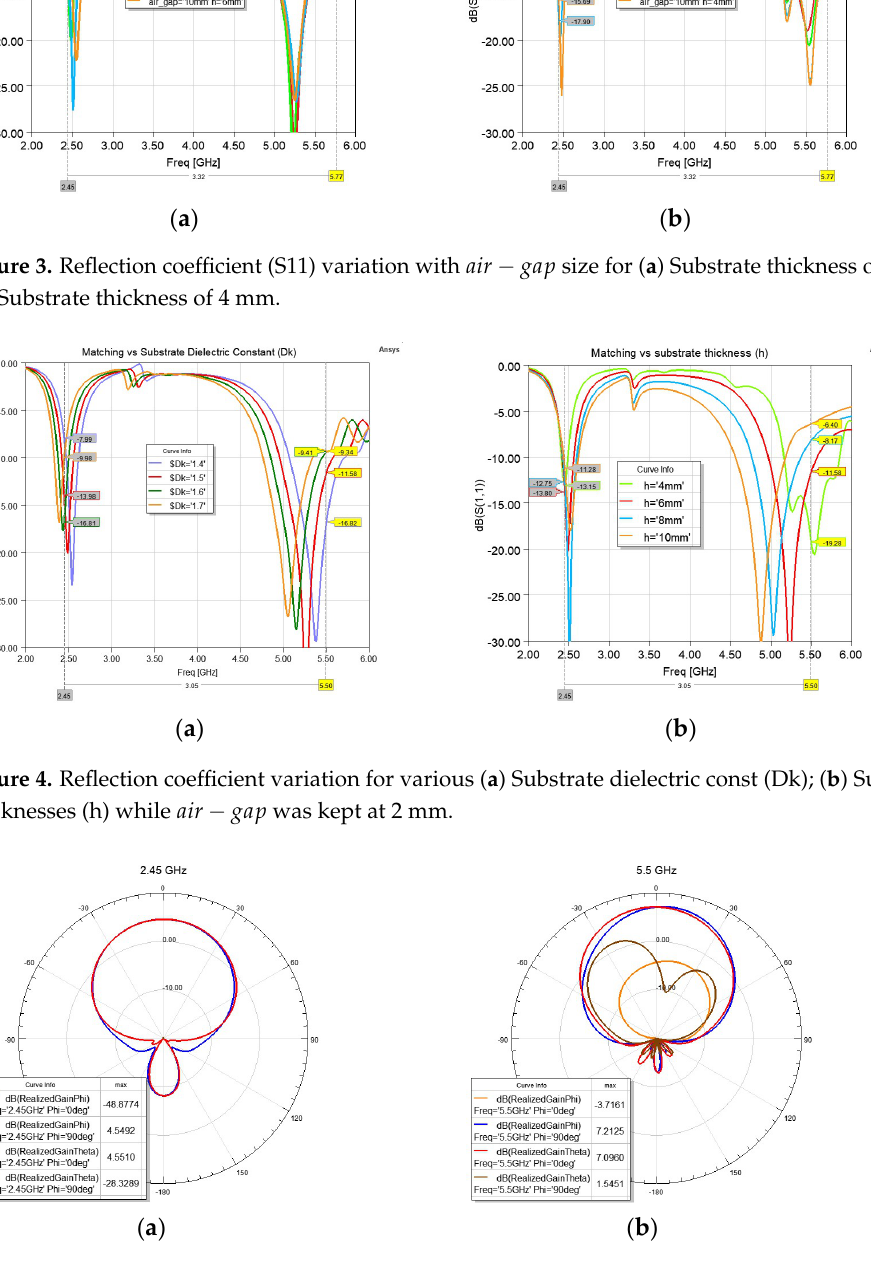
Figure 5. Radiation patterns for the antenna on a 6 mm substrate with a 2 mm 𝑎𝑖𝑟 − 𝑔𝑎𝑝 in the flat condition: ( a ) 2.45 GHz; ( b ) 5.5 GHz.